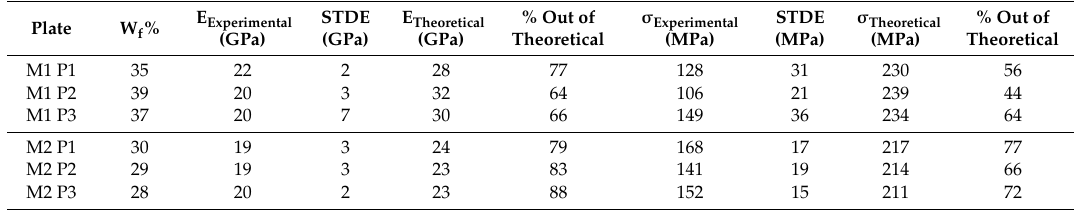
Table 2. Experimental vs. theoretical tensile modulus (E) and ultimate tensile strength ( σ ) for individual plates. Where the nomenclature Mi Pj, indicates the Method number through i and the plate number through j.